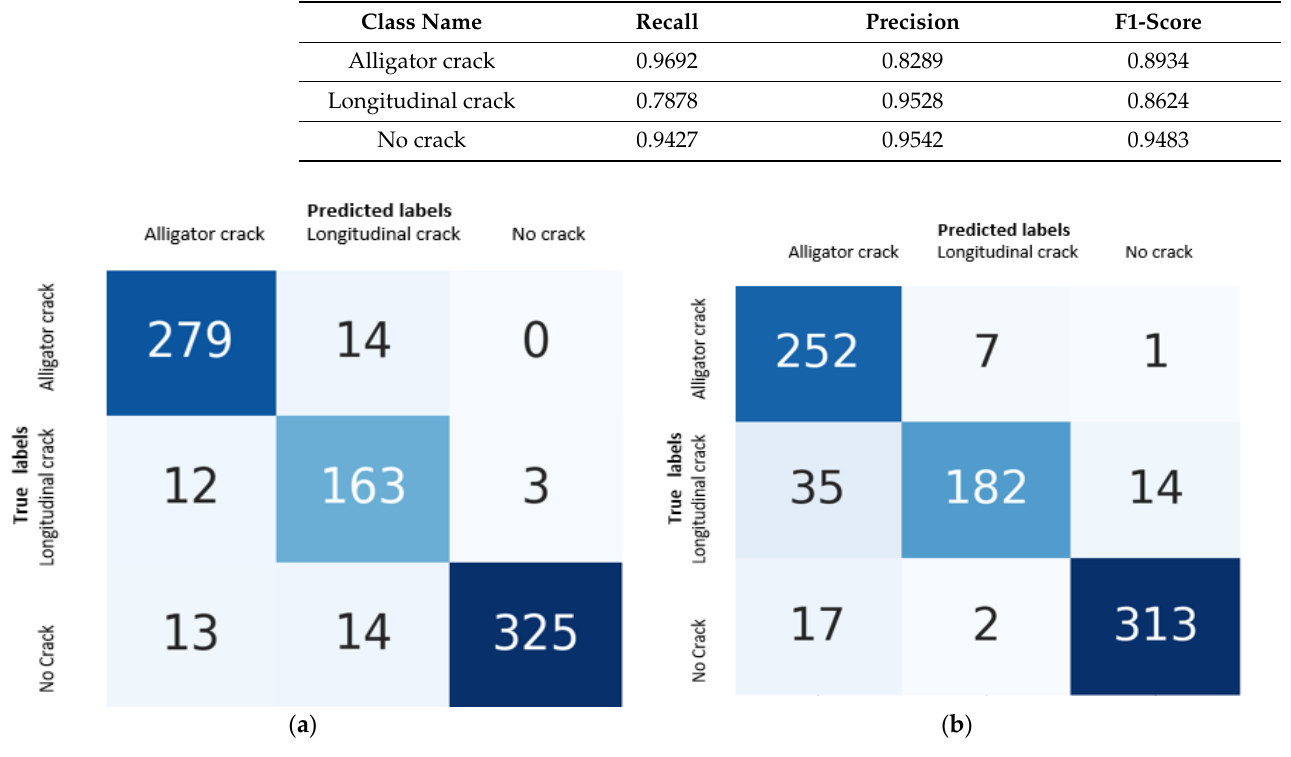
Figure 7. The confusion matrices for testing phase: ( a ) CNN, ( b ) VGG-19 . Table 4. Performance metrics for each class of CNN model . Considering a positive class, true positive (TP) is the number of testing images that are correctly classified. True negative (TN) is the number of the negative testing images correctly classified as negatives. False positive (FP) is the number of negative images that are tested and classified as positive. False negative (FN) is the number of positive images that are classified as negative after the Table 5. Performance metrics for each class of VGG-19 model .